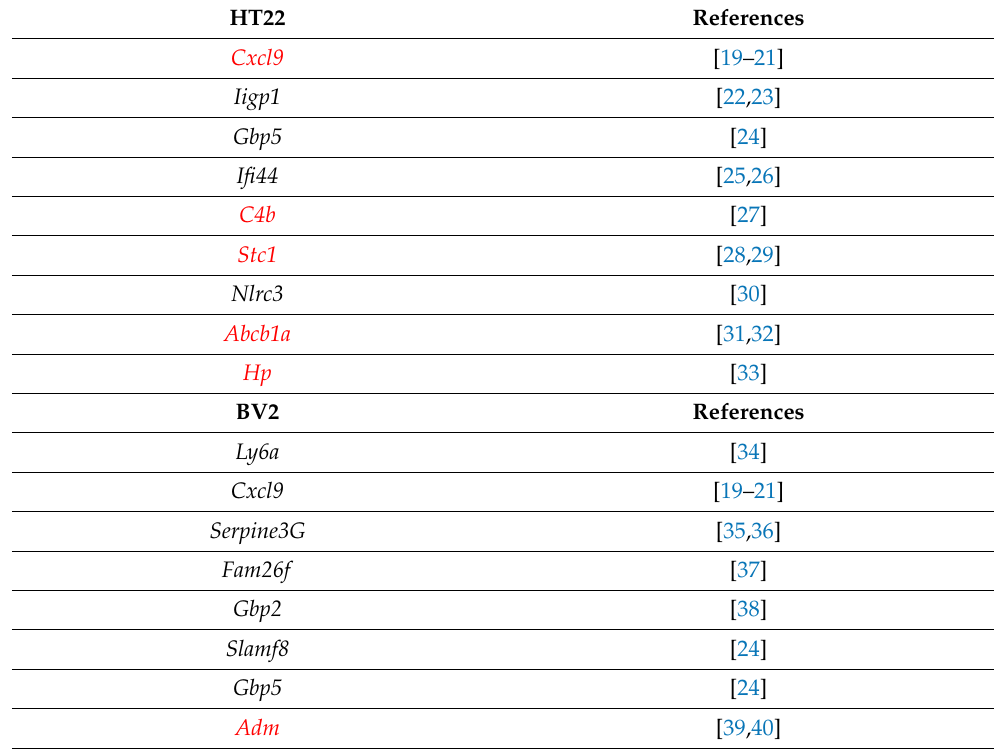
Table 3. Set of dysregulated target genes. Selection criteria: involvement in neurodegenerative disease progression in mouse model (in black) and human (in red), as reported in references, and high rate of prediction in our in vitro model highlighted by PCA analysis of treatment-affected genes.